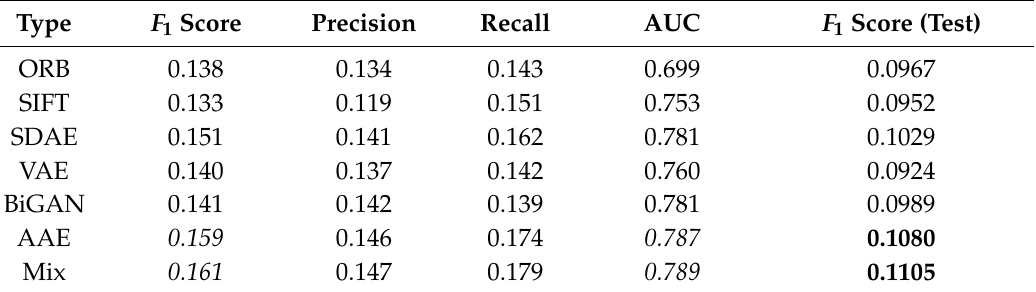
Table 4. The best metrics obtained from logistic regression for each representation learned, where Mix is the feature combination of sparse denoising autoencoder (SDAE) and adversarial autoencoder (AAE). The highest scores are shown in